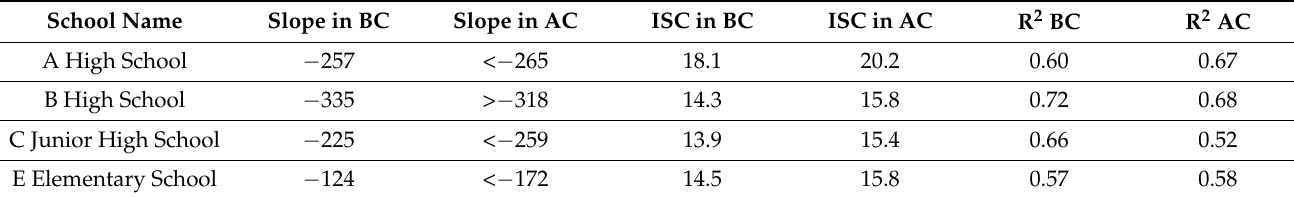
Table 2. Information of approximation